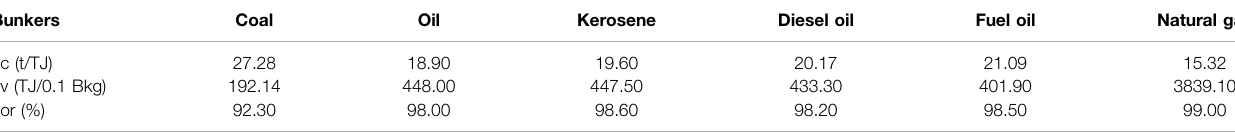
TABLE 1 | Carbon emission values of major carbon-containing bunkers in China. Bunkers